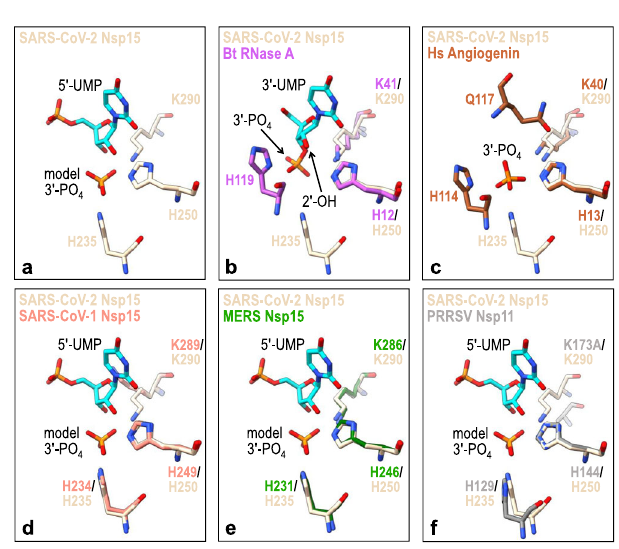
Fig. 4 SARS-CoV-2 Nsp15 active site superimposition with metal- independent endoribonucleases. a SARS-CoV-2 Nsp15 catalytic residues are shown as sticks (PDB ID 7K0R; beige) along with its bound 5 ′ -UMP nucleotide (cyan) and model 3 ′ -phosphate (3 ′ -PO 4 ). b Bos taurus (Bt) RNase A (PDB ID: 1O0N; magenta) bound to 3 ′ -UMP (cyan) 25 , c Homo sapiens (Hs) angiogenin (PDB ID: 1HBY; brown) bound to 3 ′ -phosphate (3 ′ - PO 4 ) 44 , d SARS-CoV-1 Nsp15 (PDB ID: 2H85; orange) 45 , e MERS Nsp15 (PDB ID: 5YVD; green) 4 , and f PRRSV Nsp11 (PDB ID: 5EYI; gray) 46